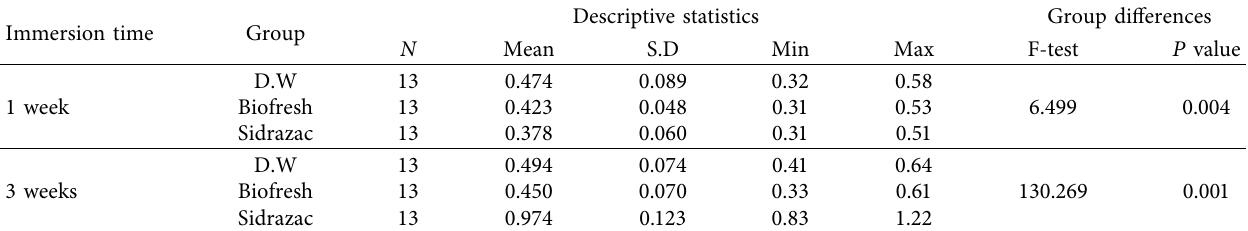
Table 1: Descriptive statistics for color change of aesthetic archwire and its diference among the three mouthwashes at each time interval. Immersion time